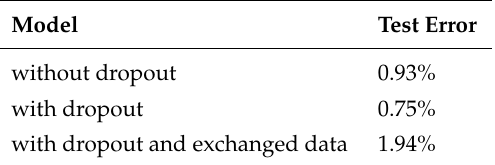
Table 1. Accuracies frequentist LeNet.